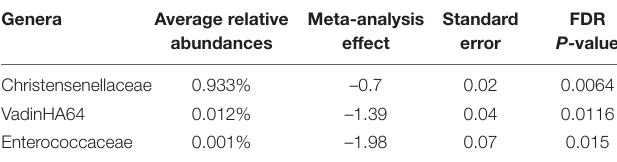
TABLE 5 | Meta-analysis of all sites combined for the genera remained significant. Genera Average relative abundances